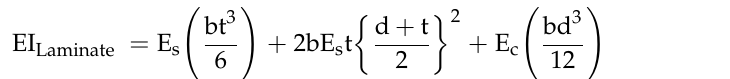
Figure 6. ( a ) Variation of wall and flange angles with laminate thickness ( b ) Variation of radius of curvature of the wall with laminate thickness.